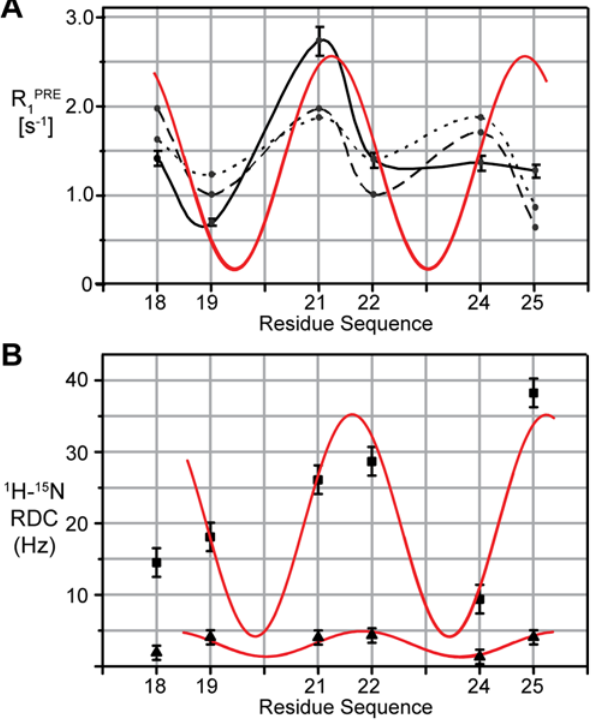
Figure 3. Orientation of ETM relative to the detergent phase and a -helical geometry. (A) PRE rates of 1 H N nuclei for residues A22, V24, V25, L18, L19 and L21 (black solid line), superimposed to predicted PRE from the ETM pentamer using either the immersion depth method (black dotted line) or the distance from the center method (black dashed line)(Fig. S3, BC). (B) RDCs for 1 H N nuclei corresponding to A22, V24, V25, L18, L19 and L21 in 4% and 8% polyacrylamide gels compressed axially ( m ) or radially ( & ), respectively. Best-fit sine waves of 3.6 periodicity (red lines) are superimposed onto both PREs and RDCs plots, and show that the stretch of residues 19–24 adopt a regular a - helical structure. The RDCs of flanking residue L18 could not be fitted to this , 3.6 periodicity, suggesting a local deviation from ideal a